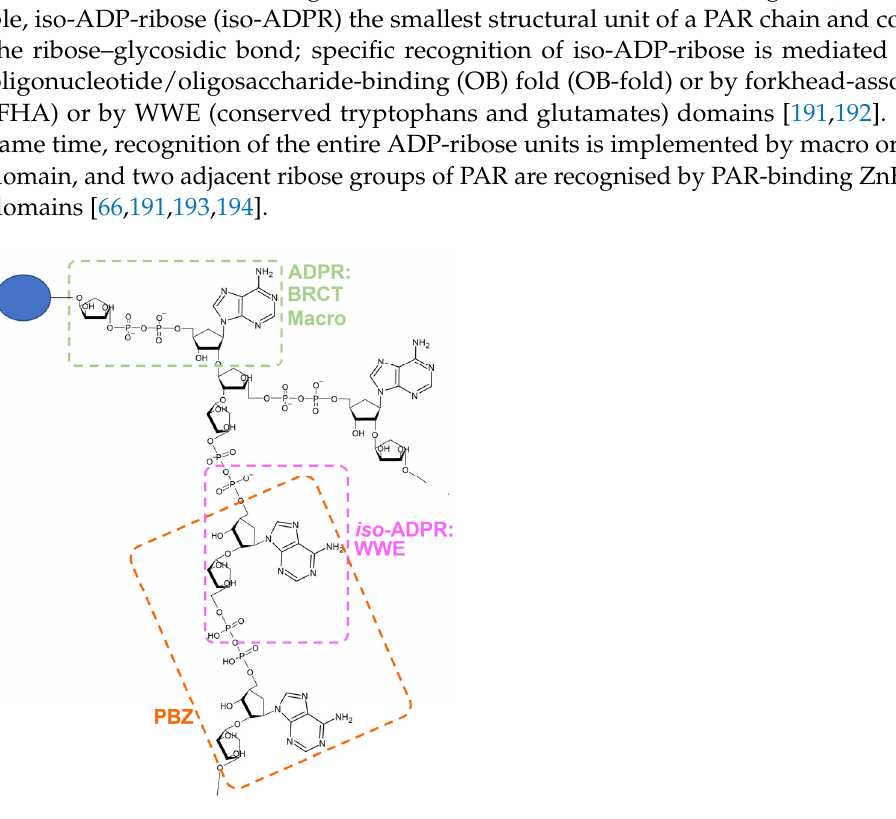
Figure 5. PAR structure and the specific motif affecting preferences of various protein domains.